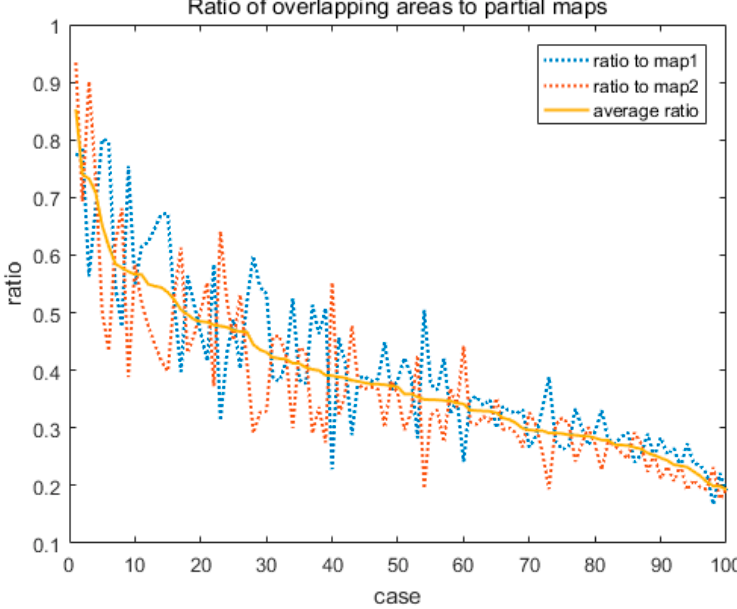
Figure 7. The ratio of overlapping areas to the various pairs of the individual maps. One hundred different pairs of individual maps were randomly produced from the whole map in simulations and rearranged according to the average ratio of overlapping areas to individual maps.